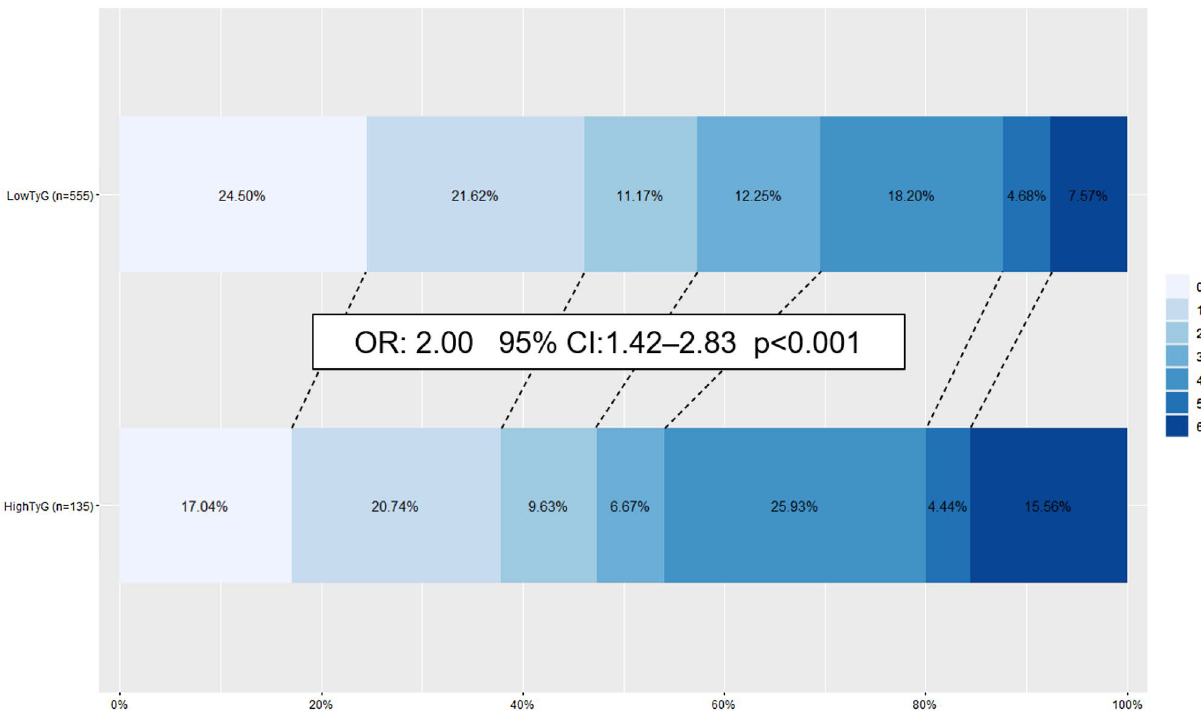
Figure 2. Ordinal shift analysis—comparison of mRS distribution between ‘low TyG’ and ‘high TyG’ patients. OR represents adjusted multivariate ordinal logistic regression of TyG index in model against ordinal mRS, adjusting for hypertension, age, admitting NIHSS and LVO status. Legend (right) demonstrates how mRS is represented by colours from 0 (in light blue) to 6 (in dark blue). Values with missing mRS values have been excluded from diagram. OR odds ratio, 95% CI 95% confidence interval, p p-value calculated from ordinal logistic regression, TyG index triglyceride-glucose index, mRS modified Rankin scale, NIHSS National Institutes of Health Stroke Scale, LVO large vessel occlusion.